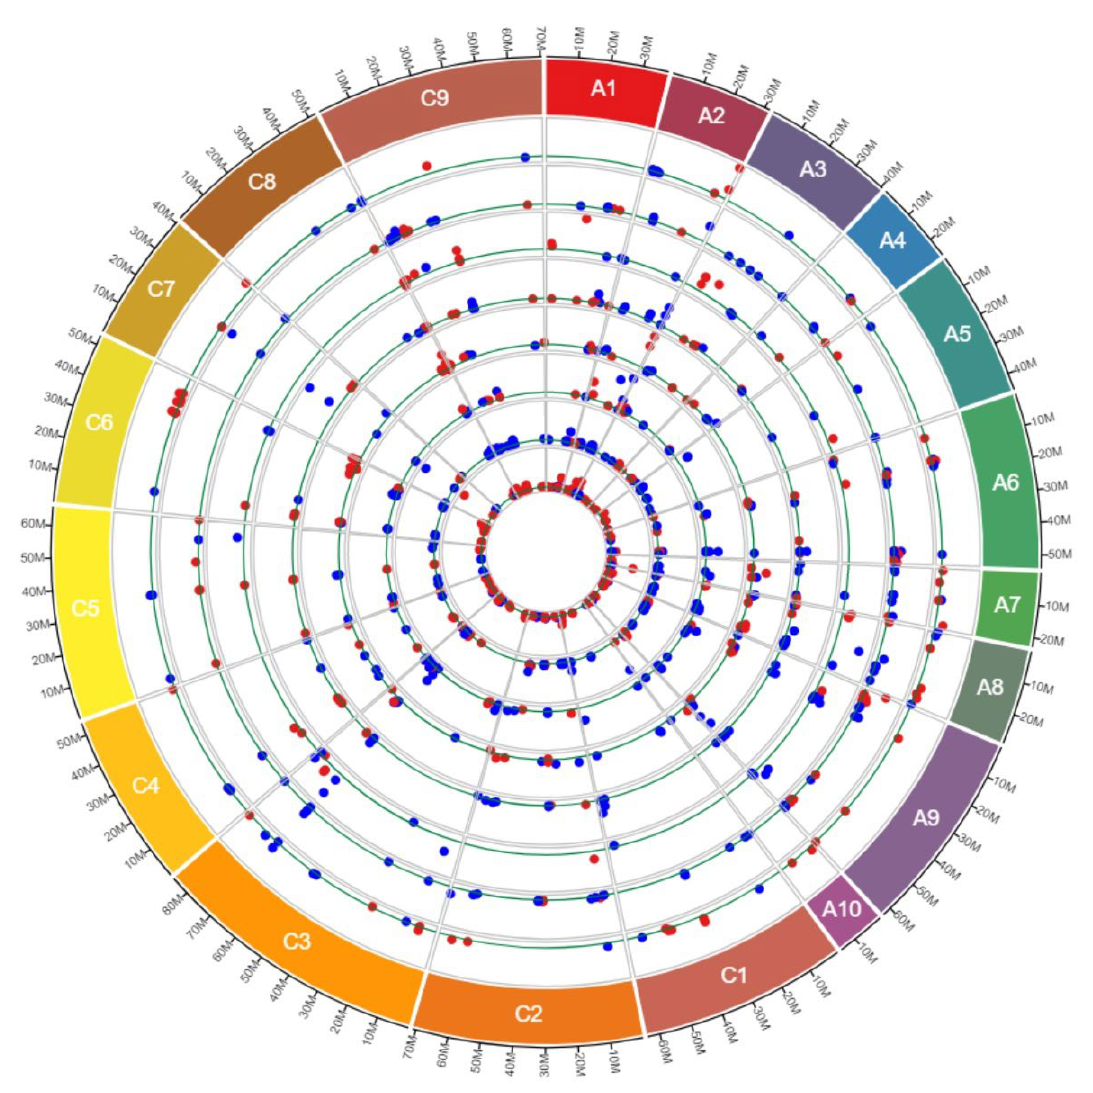
Figure 2. The distribution and size of CNV events in RGAs (red and blue dots represents deletions and duplications, respectively) across the chromosomes of eight winter type and blackleg resistant B. napus cultivars. The tracks from outer to inner show chromosomes, Ascona, English Giant, Hansen × Gaspard, Milena, Pacific, Pirola, Tina and Wilhelmsburger. The green line shows the 1000 bp threshold. Ax and Cx in the outer coloured boxes are presenting chromosomes number.